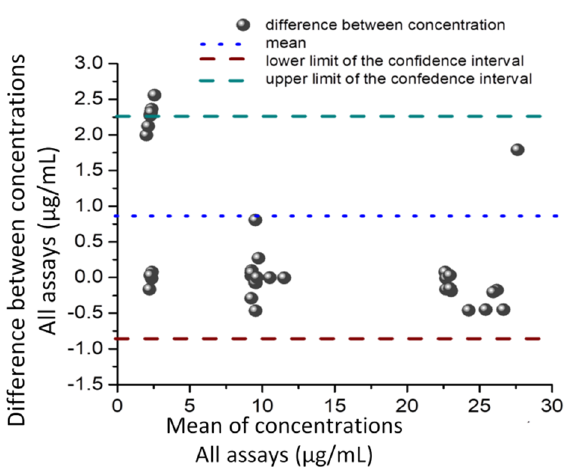
Figure 7. Bland-Altman analysis for GMB determinations in pharmaceutical compounds by amperometry, DPV, UV-VIS and by the HPLC-UV assays. Plotted points represent the differences between concentrations measured by the four methods versus the mean of these methods. The medium dotted horizontal line is the estimated mean bias of 0.725 μg/ mL, and the two short, dashed horizontal lines represent the upper (green) and lower (brown) limits of the 95% confidence interval for agreement determined by the mean SD = ±5.31.